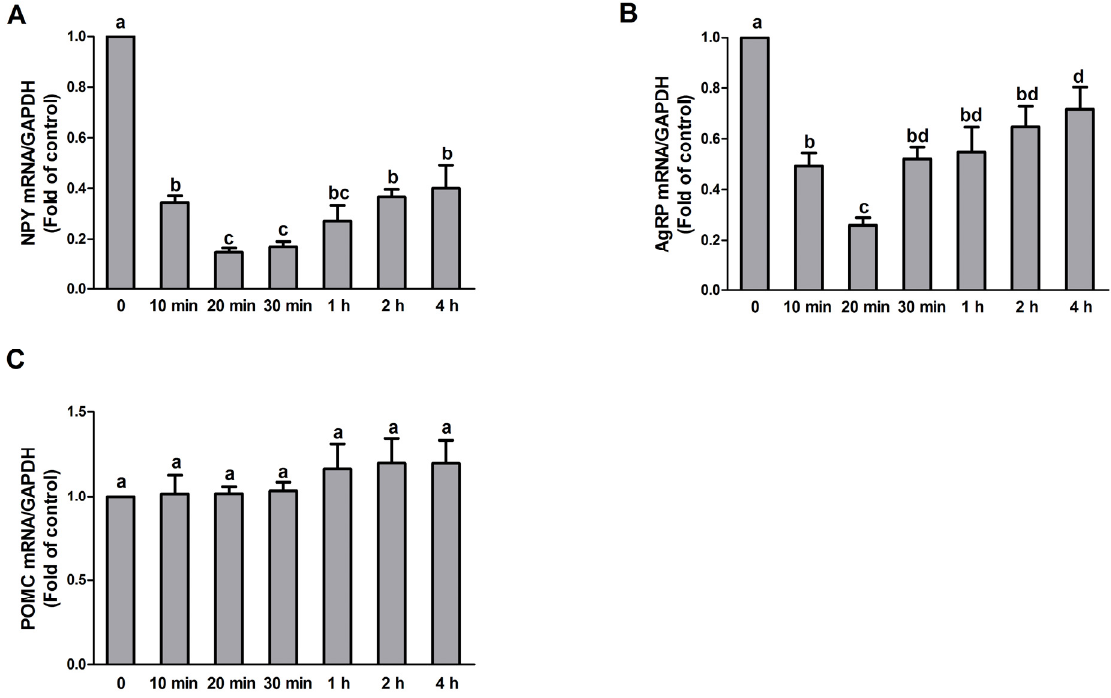
Figure 1. Time-dependent effect of PA on NPY, AgRP, and POMC expression in N1E-115 cells. Quantitative real-time PCR analysis of NPY, AgRP, and POMC performed with RNA extracted from N1E-115 cells treated with 10 µ mol/L PA for different durations ( A – C ), respectively. Quantified mRNA levels were normalized to GAPDH and presented relative to 10 µ mol/L PA for 0 min. Data are expressed as means ± SEM of three different experiments. Groups sharing different letters above the bars indicate statistically significant differences ( p < 0.05), while those denoted by the same letters are insignificant ( A – C ). PA: palmitic acid group.